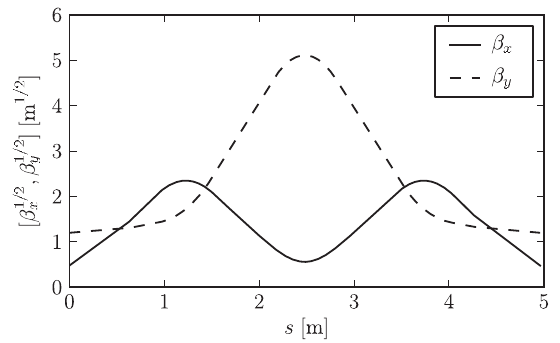
FIG. 10. Beta functions in one cell of the carbon lattice as calculated with S-CODE .